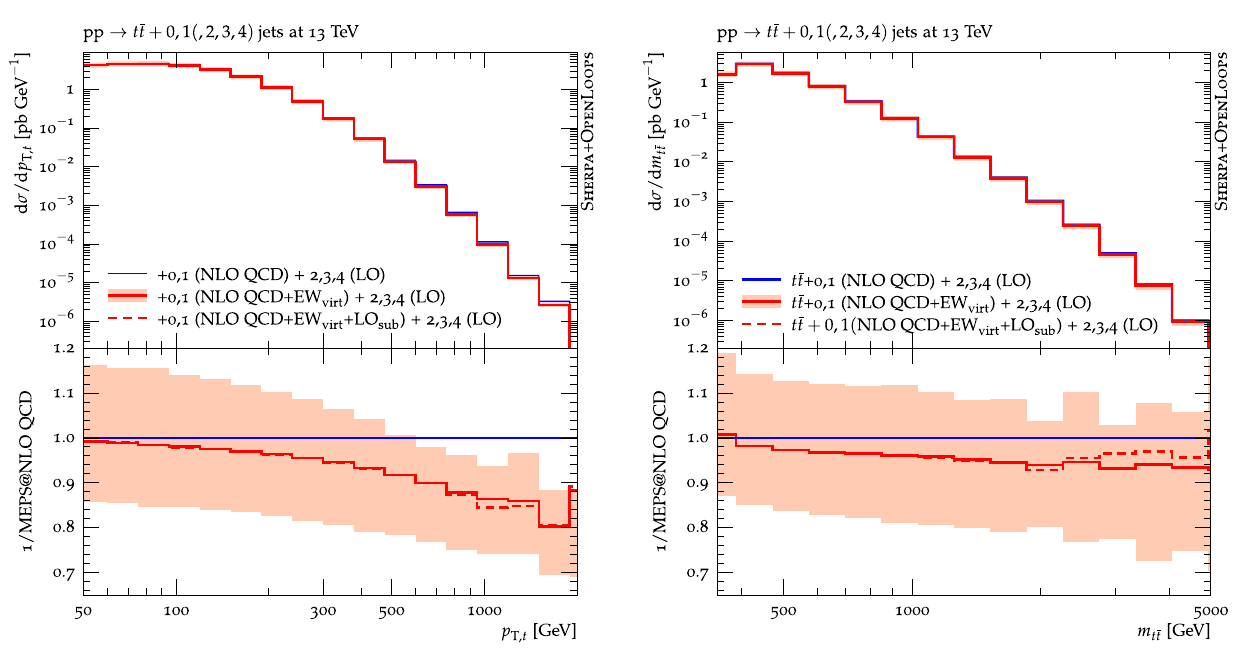
+ EW virt predictions and the effect of subleading Born contributions. Error bands are due to QCD scale variations